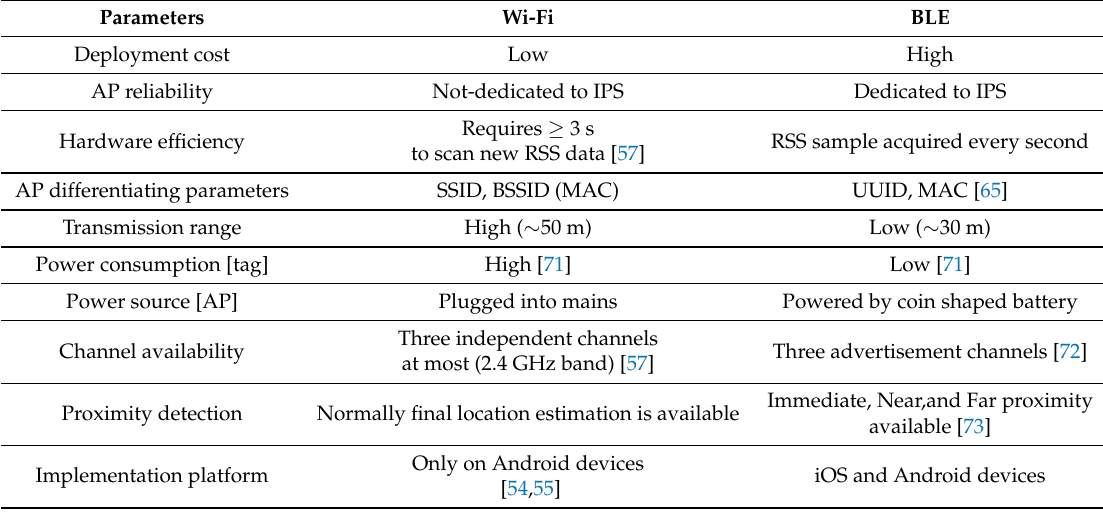
Table 1. Comparison of Wi-Fi and Bluetooth Low Energy (BLE) technology in terms of